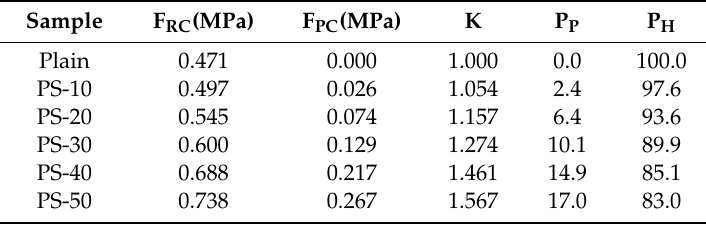
Table 6. Integrate performance of the pozzolanic activity of phosphorus slag in cement mortars at 90